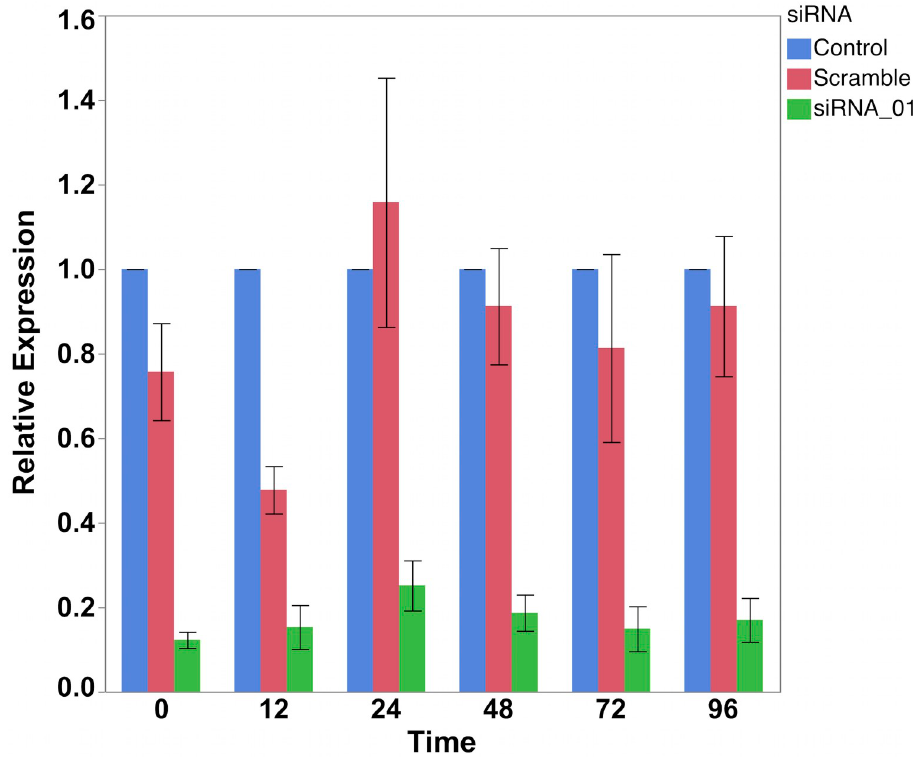
Fig 8. Expression of SYNGR2 in PK15 cells transfected with SYNGR2 specific siRNA-01, scramble siRNA and non-transfected controls following inoculation with the UNL2014001 PCV2b strain. Expression of SYNGR2 in siRNA-01 and scramble siRNA treated cells is presented as relative expression to the control